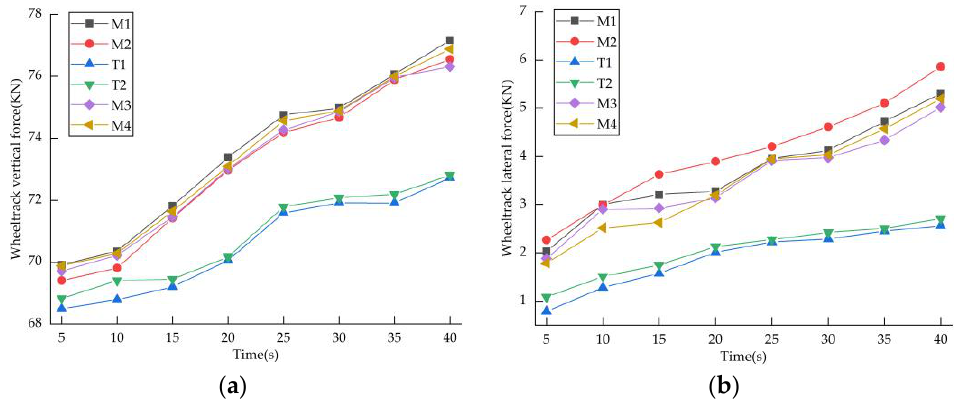
Figure 5. Wheel–rail force of urban rail train in operation: ( a ) wheel–rail vertical force; and ( b ) wheel– rail lateral force.